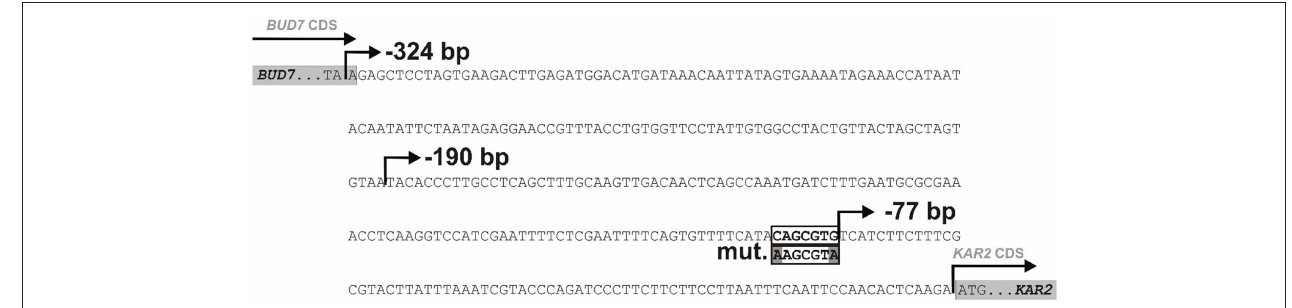
FIGURE 1 | The upstream region of the KAR2 CDS in P. pastoris X33 . The nucleotide sequence located upstream of the KAR2 CDS and downstream of the CDS of the previous gene (B UD7 ) in the genome of P. pastoris X33. One potential UPRE (CAGCGTG) was identified in the KAR2 upstream region, starting − 84 bp upstream of the KAR2 CDS. The following variants of the KAR2 upstream region were used to control the expression of sfGFP : • full length KAR2 upstream region (FL, − 324 bp); • truncated variant of KAR2 upstream region, still containing native UPRE sequence ( − 191 bp); • truncated variant of KAR2 upstream region with two single mutations (84C → A, 78G → A) in the UPRE sequence ( − 191 bp mut.); truncated variant of KAR2 upstream region lacking the UPRE sequence ( − 77